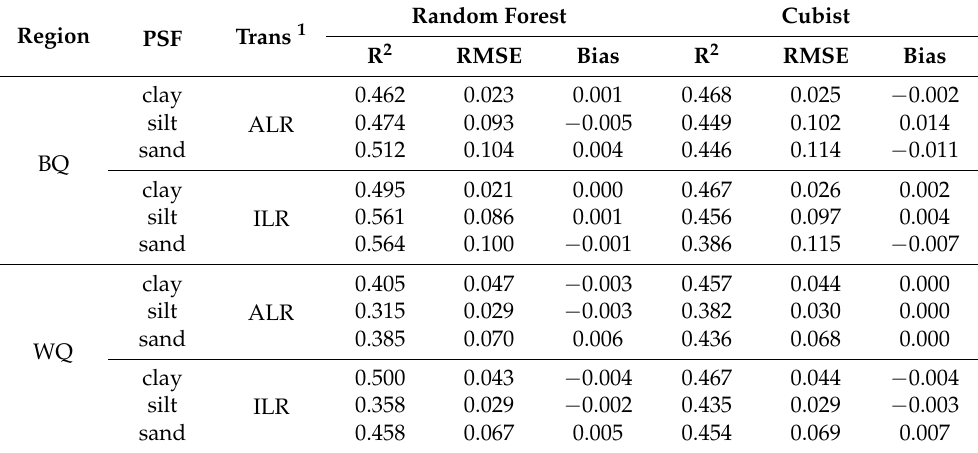
Table 3. Best performance by the combination of log-ratio transformation, covariate selection, and machine learning approach in predicting soil particle size fractions. Region PSF Trans